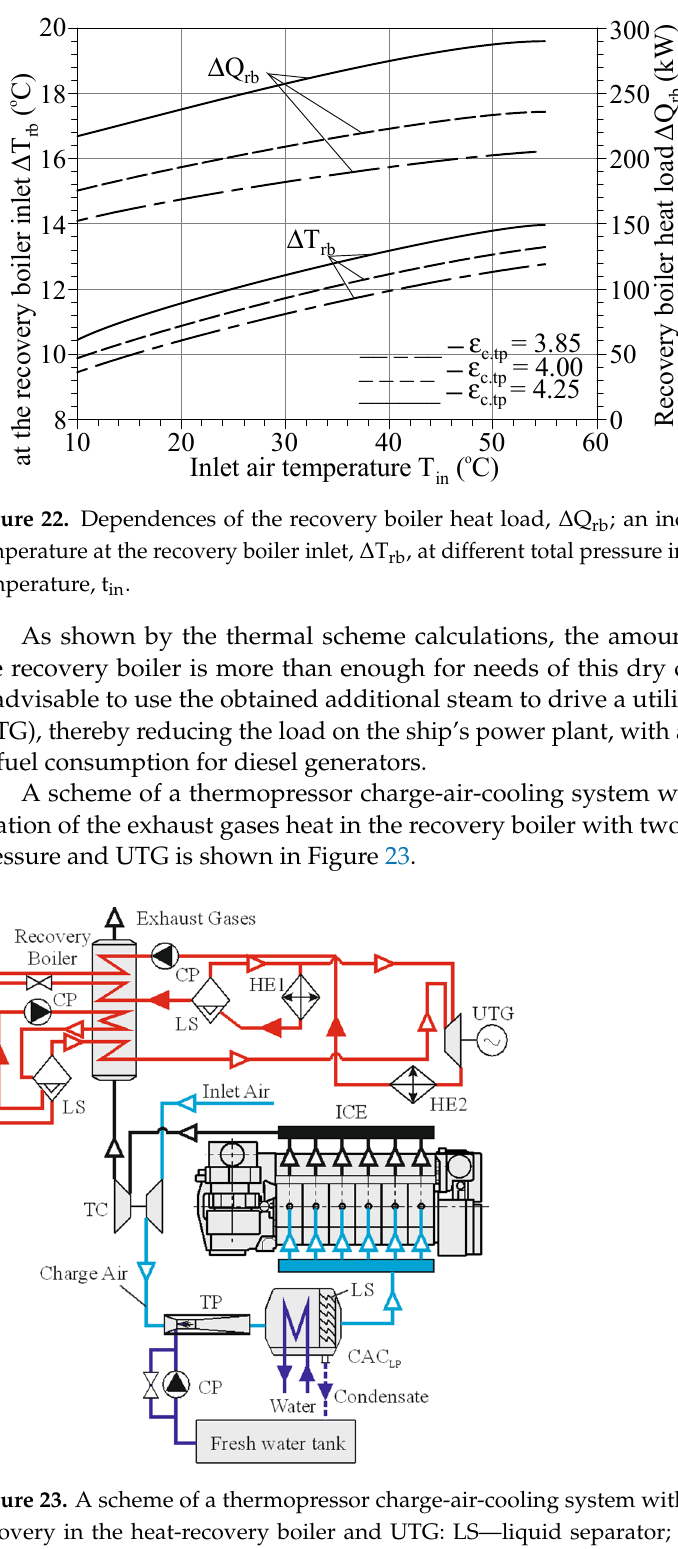
Figure 21. Dependences of the water pump power, N w ; the water mass flow for injection in the thermopressor, G w ; an increase in the air moisture content, Δ d tp , at different total pressure increase, ε c . tp , on the inlet air temperature, T in .